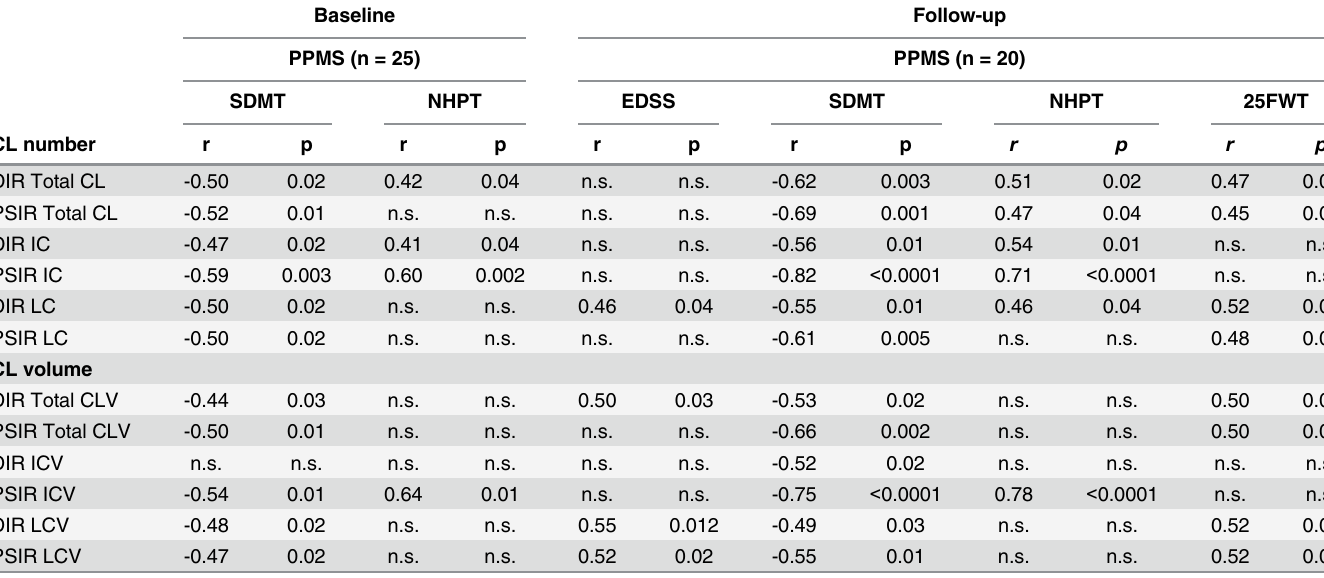
Table 3. Significant baseline and follow-up correlations between CL counts and volumes and clinical variables (without correction for age and gender).